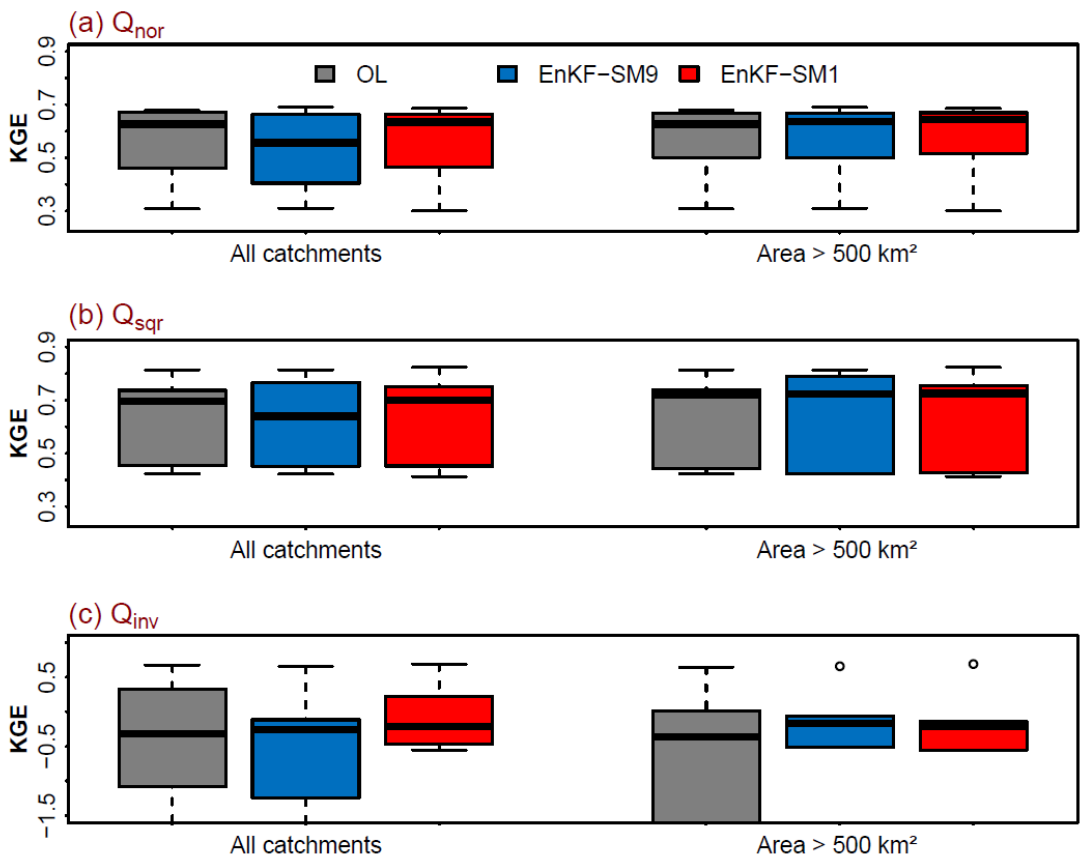
Figure 8. Performance metrics in streamflow simulation in ( a ) normal-, ( b ) square root-, and ( c ) inverse-time series for open loop (OL)-, EnKF-SM9-, and EnKF-SM1-based SWAT model during the period 2017–2019. With respect to all catchments, total simulated catchments are 8. With respect to catchments having an area greater than 500 km², total simulated catchments are 6.